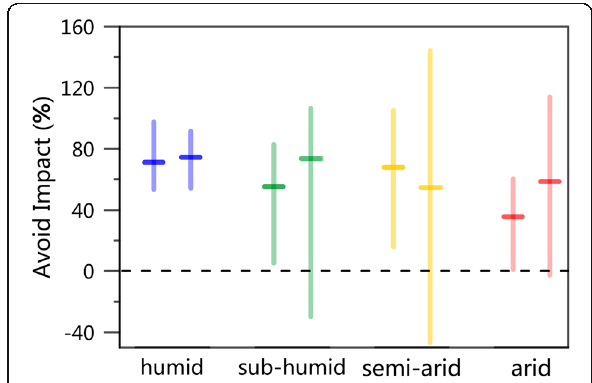
Fig. 5 Changes in the area of arid/humid regions over Asia that are avoided in less warming scenarios. Left bars are the 2.0 °C scenario compared with the INDC-pledge scenario, and right bars are the 1.5 °C scenario compared with the INDC-pledge scenario. Horizontal lines denote multimodal median, and the length of the vertical lines denotes the interquartile